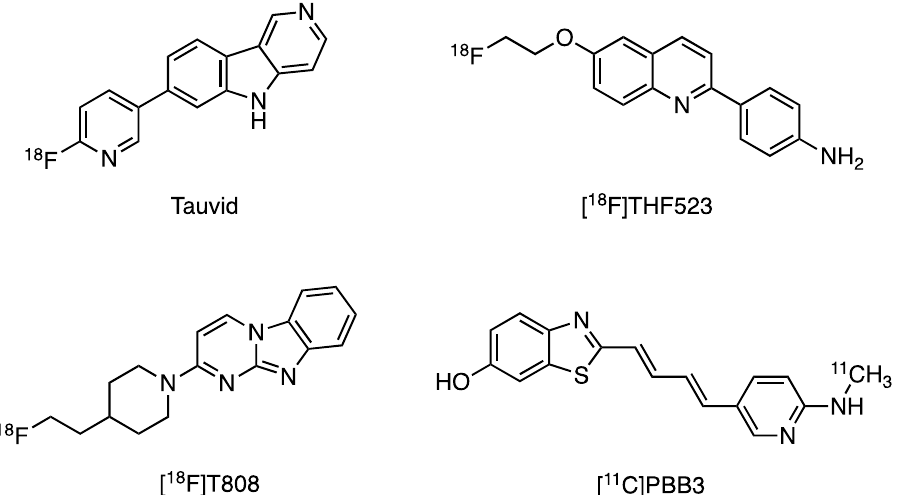
Figure 3. First-generation tau positron emission tomography (PET) tracers, including Tauvid.